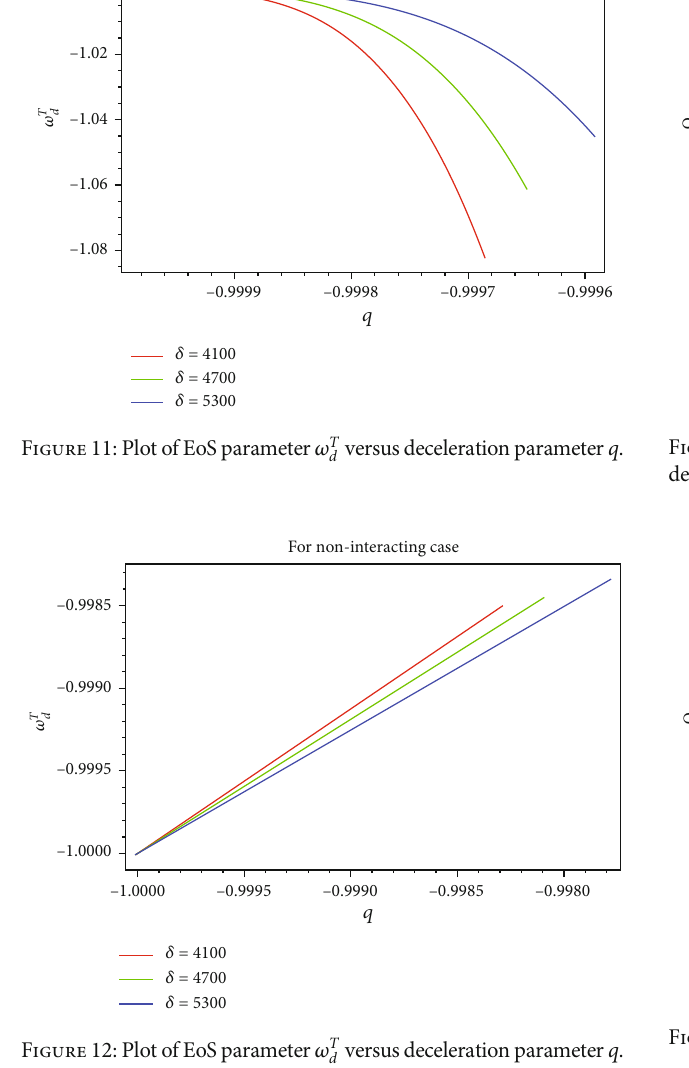
versus deceleration parameter q . d